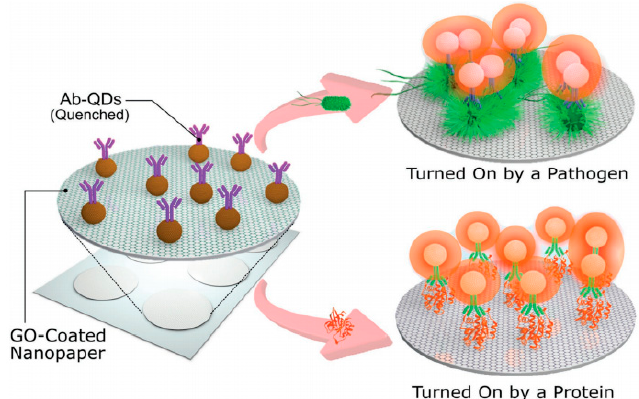
Figure 4. Operational concept of the immunosensing approach (schematic representation, not to scale). The hydrophilic, porous and photoluminescence-quenching character of GONAP allows for the adsorption and quenching of Ab-QDs, whereas photoluminescence recovery is triggered by the immunocomplex formation phenomenon, which involves a series of forces and interactions detaching the antigen-Ab-QD complex. Nevertheless, the antigen is then attached onto GONAP surface working as spacer between GONAP and Ab-QDs and hindering highly efficient nonradiative energy transfer. The immunosensing platform can be turned “On” by either big-sized analytes (pathogens) or small-sized analytes (proteins). Reprinted with permission from Advance Functional Materials,